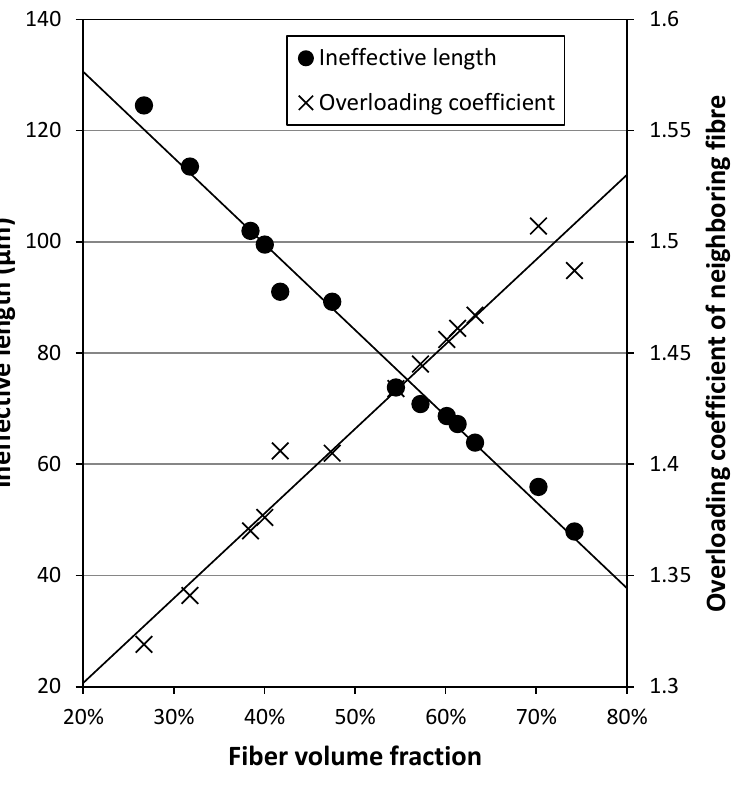
Figure 6. Overloading coefficient and ineffective length for a non-reinforced matrix as a function of fiber volume